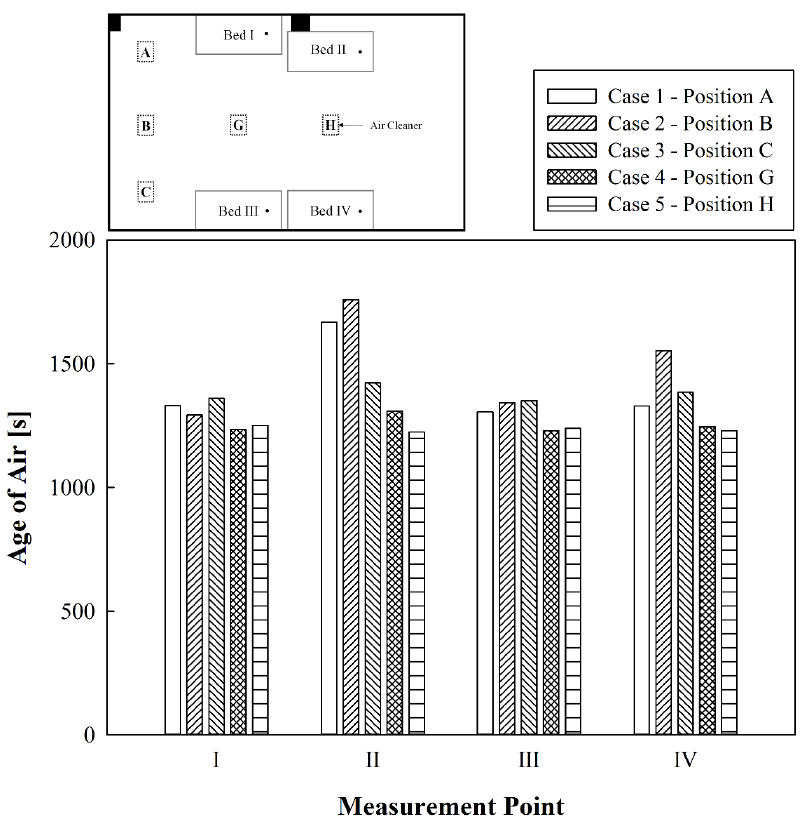
Figure 6. Comparative results of the age of air at locations where only the air cleaner was operated.